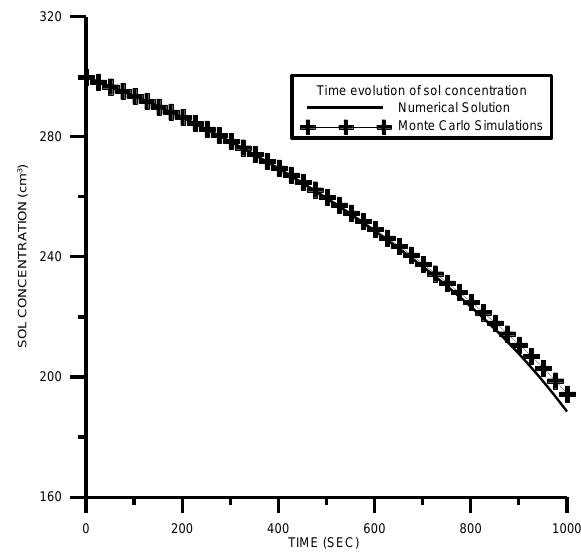
Fig. 4. Time evolution of the sol concentration obtained from the numerical solution of the kinetic collection equation (solid line) and from the Monte Carlo algorithm (crosses).